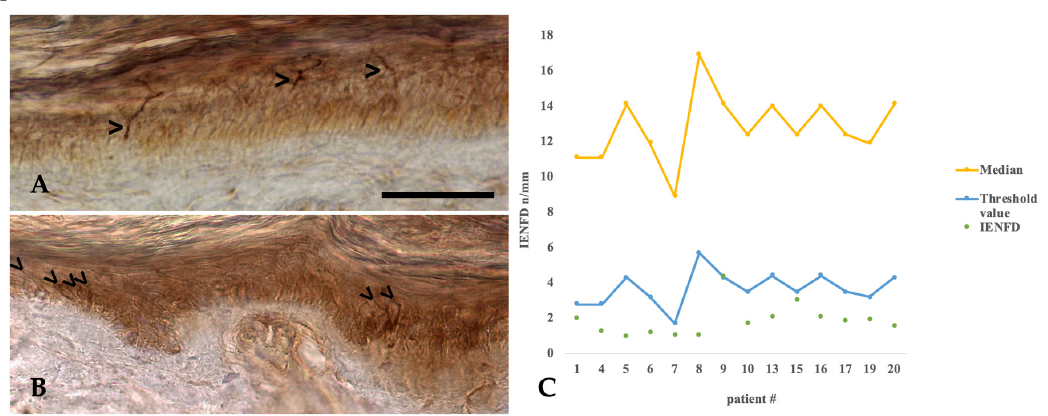
Figure 4. Intraepidermal nerve fiber density (IENFD). ( A ) Immunhistochemical staining for a 31 years old patient with schwannomatosis. Analysis of intraepidermal nerve fiber density (IENFD). The arrowheads mark three intraepidermal nerve fibers (mean fiber density 1.5 / mm in the biopsy), scale bar 50 μ m. ( B ) Immunhistochemical staining from a 37-year-old healthy volunteer. The arrowheads mark six intraepidermal nerve fibers (mean fiber density 6.7/mm in the biopsy), the scale is the same as in A. ( C ) IENFD (mean) with age-adjusted reference values (threshold is the 5% normative of the age and sex dependent reference group and mean of the reference group).